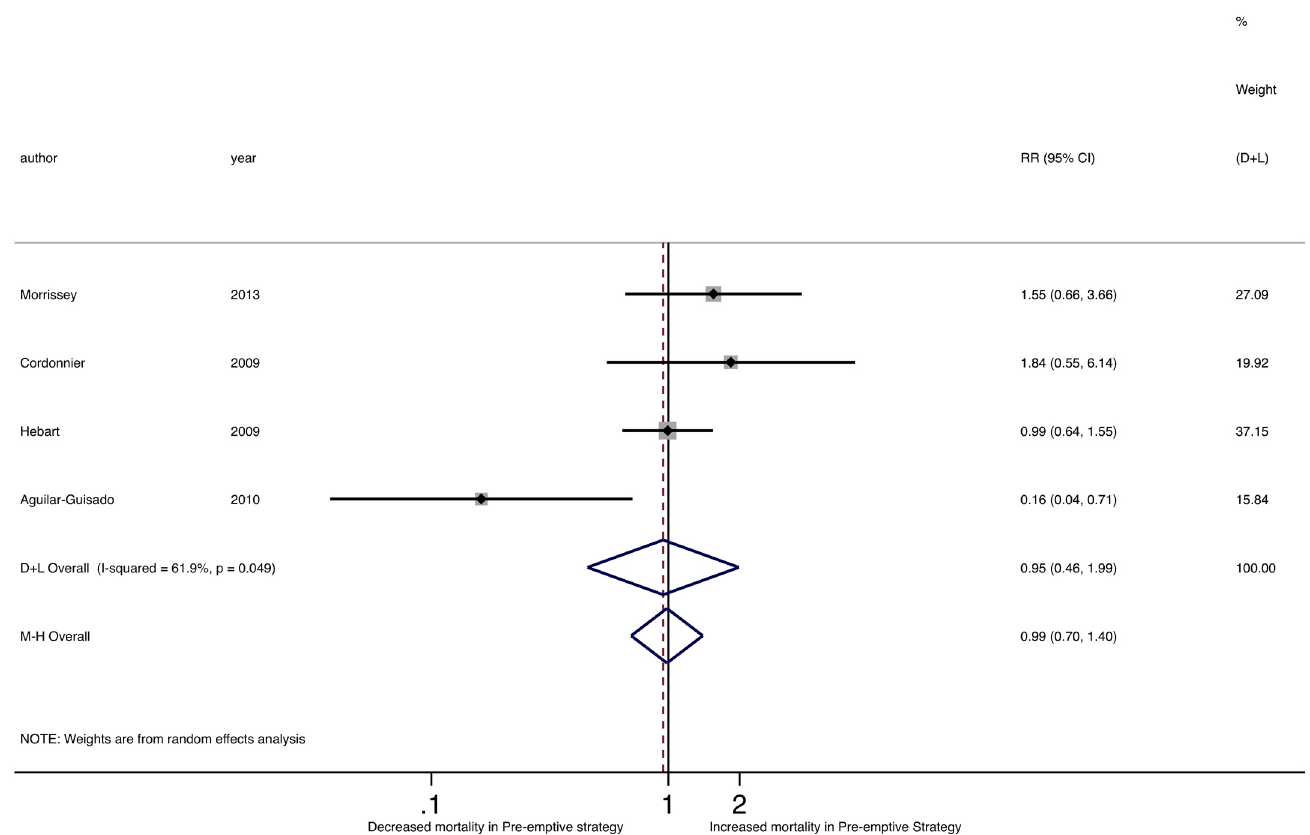
Fig 7. Forest plot of pooled relative risk of overall mortality comparing pre-emptive to empirical strategies.